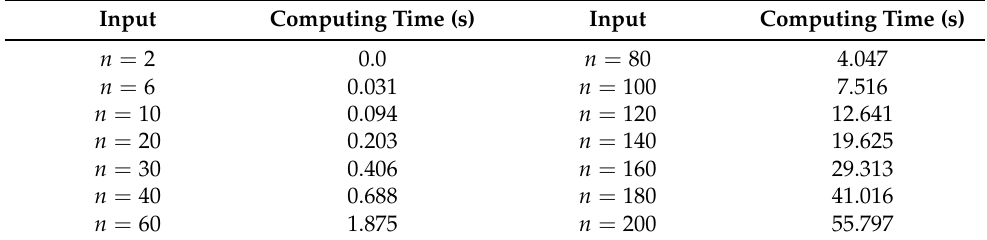
Table 1. Computing time.